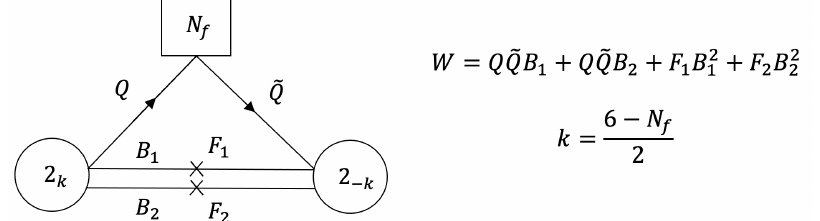
Figure 2 . The 3 d theories associated with the compactification of the 5 d E N (cid:0)p (cid:1) torus with flux 1 8 − N f ; 1 , 1 , . . . , 1 , which is twice the flux of each of the constituent 2